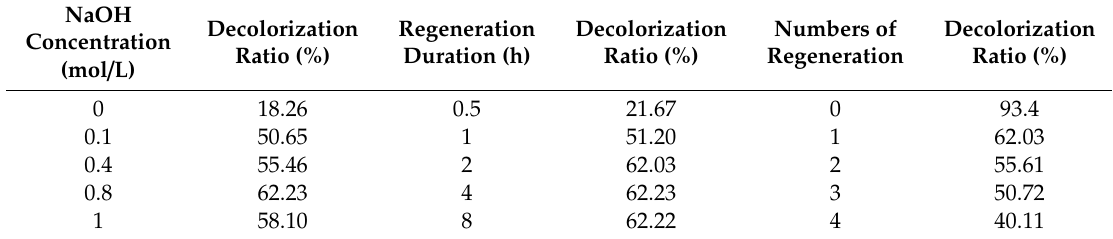
Table 6. E ff ect of NaOH concentration, regeneration duration and numbers of regenerations on decolorization ratio. To investigate the NaOH concentration, 8 h regeneration duration was employed; to investigate the regeneration duration, 0.8 mol / L NaOH was employed; to investigate the number of regenerations, 8 h regeneration duration and 0.8 mol / L NaOH was